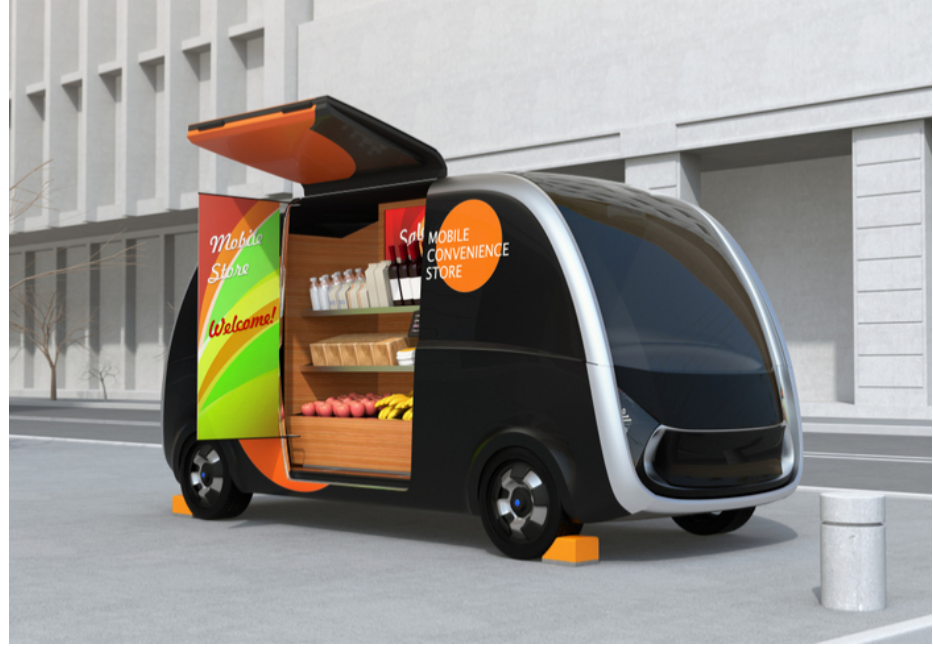
Figure 1. Sample picture of a Mobile Grocery Store from [75].